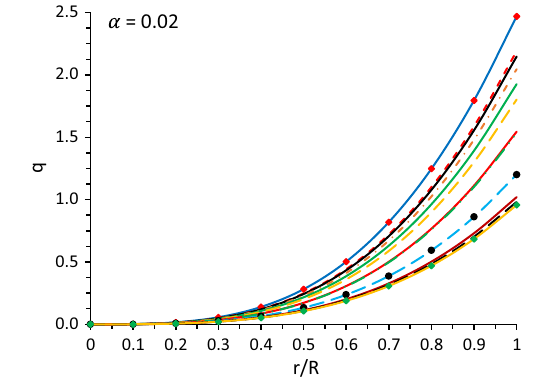
Fig. 2 The variation of electric charge ( q ) versus radius r / R by taking the numerical values of the constants a = 0 . 003, b = 0 . 0000053, β = 1 . 1, and γ = − 0 . 001. The description of the curves are given at the